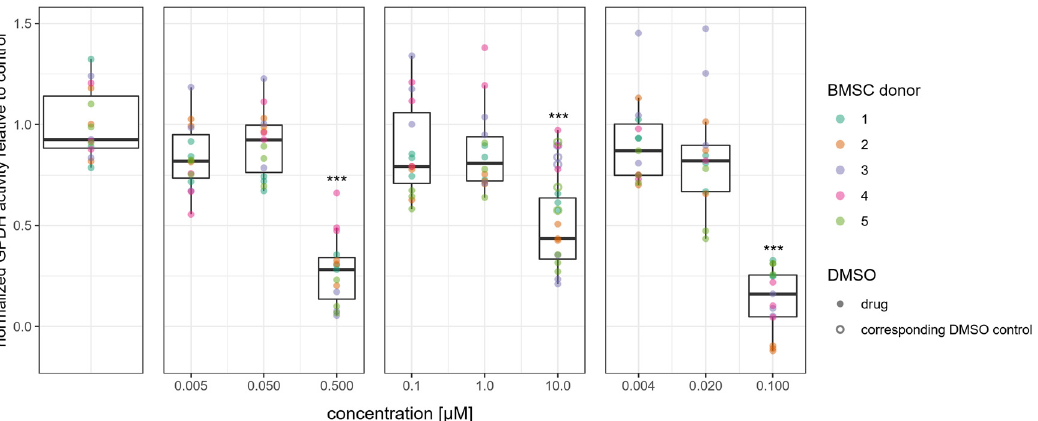
Figure 6. Drug effect on lipid biosynthesis in adipogenically differentiated BMSCs. Activity of glycerol-3-phosphate dehydrogenase (GPDH) at 21 days of culture in adipogenic differentiation conditions with melflufen, melphalan and doxorubicin added at indicated concentrations. GPDH activity is normalized by total protein content and is presented relative to the control. Dots represent individual culture wells with a color-coded donor cell line. Open circles indicate DMSO vehicle controls for 10 mM melphalan *** denotes p < 0.001 with Dunn’s test.